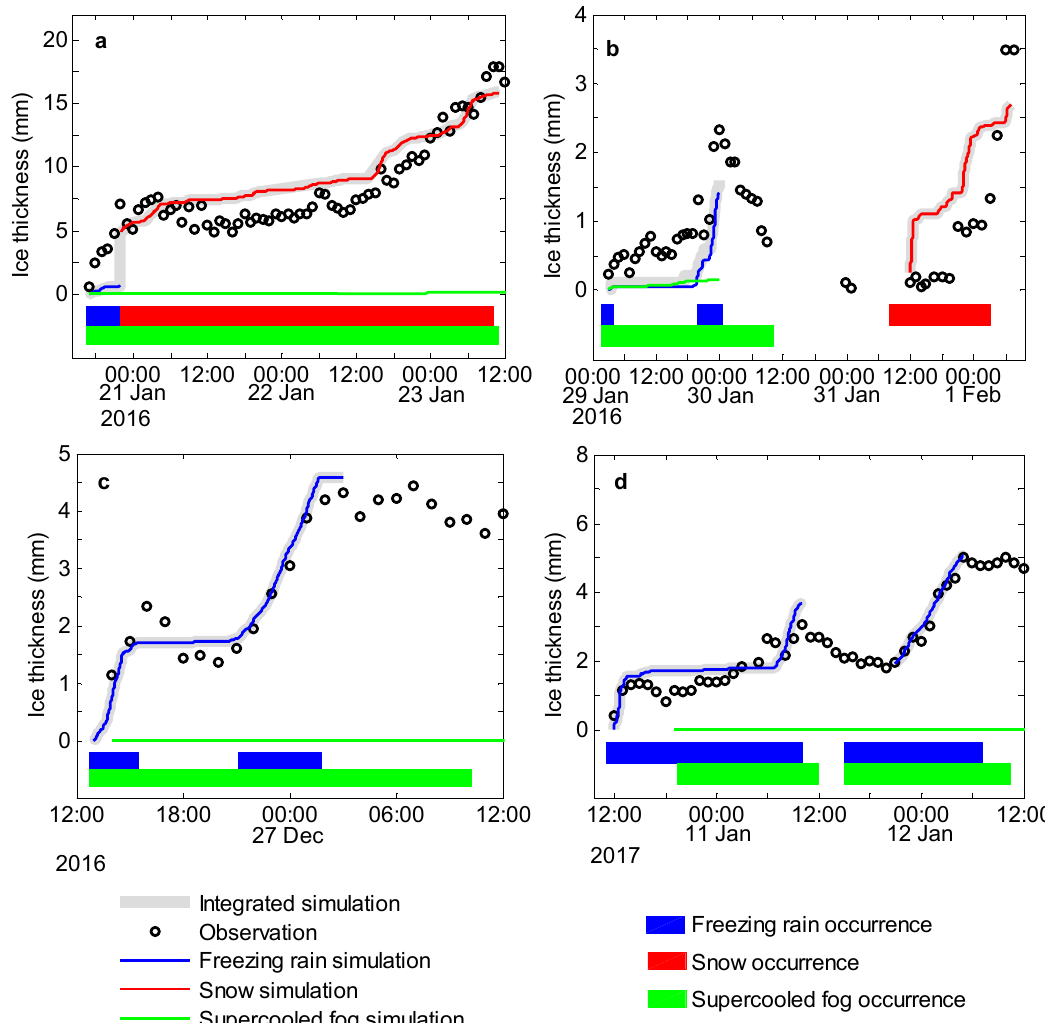
Figure 10. Ice thickness simulation results using the freezing rain (blue lines), snow (red lines), supercooled fog (green lines), and integrated (gray lines) ice accumulation models: ( a ) case 1; ( b ) case 2; ( c ) case 3; and ( d ) case 4. Blue, red, and green rectangles indicate the occurrences of freezing rain, snow, and supercooled fog, respectively.